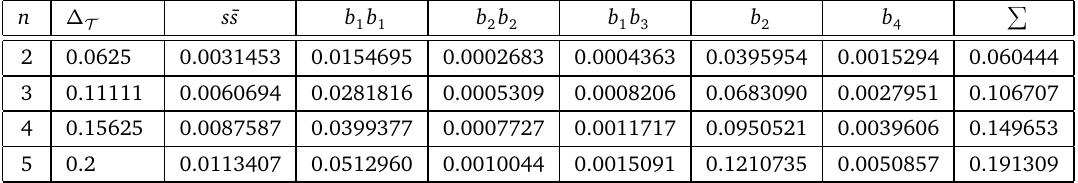
Table 3: One- and two-particle contributions to the ∆ sum rule for ξ “ 0.22108. For this value of the coupling the first four breathers can be formed and approximately half the value of ∆ comes from breather contributions. Even after neglecting the T b b b terms b , b and b the rule is 95% 3 3 2 4 4 4